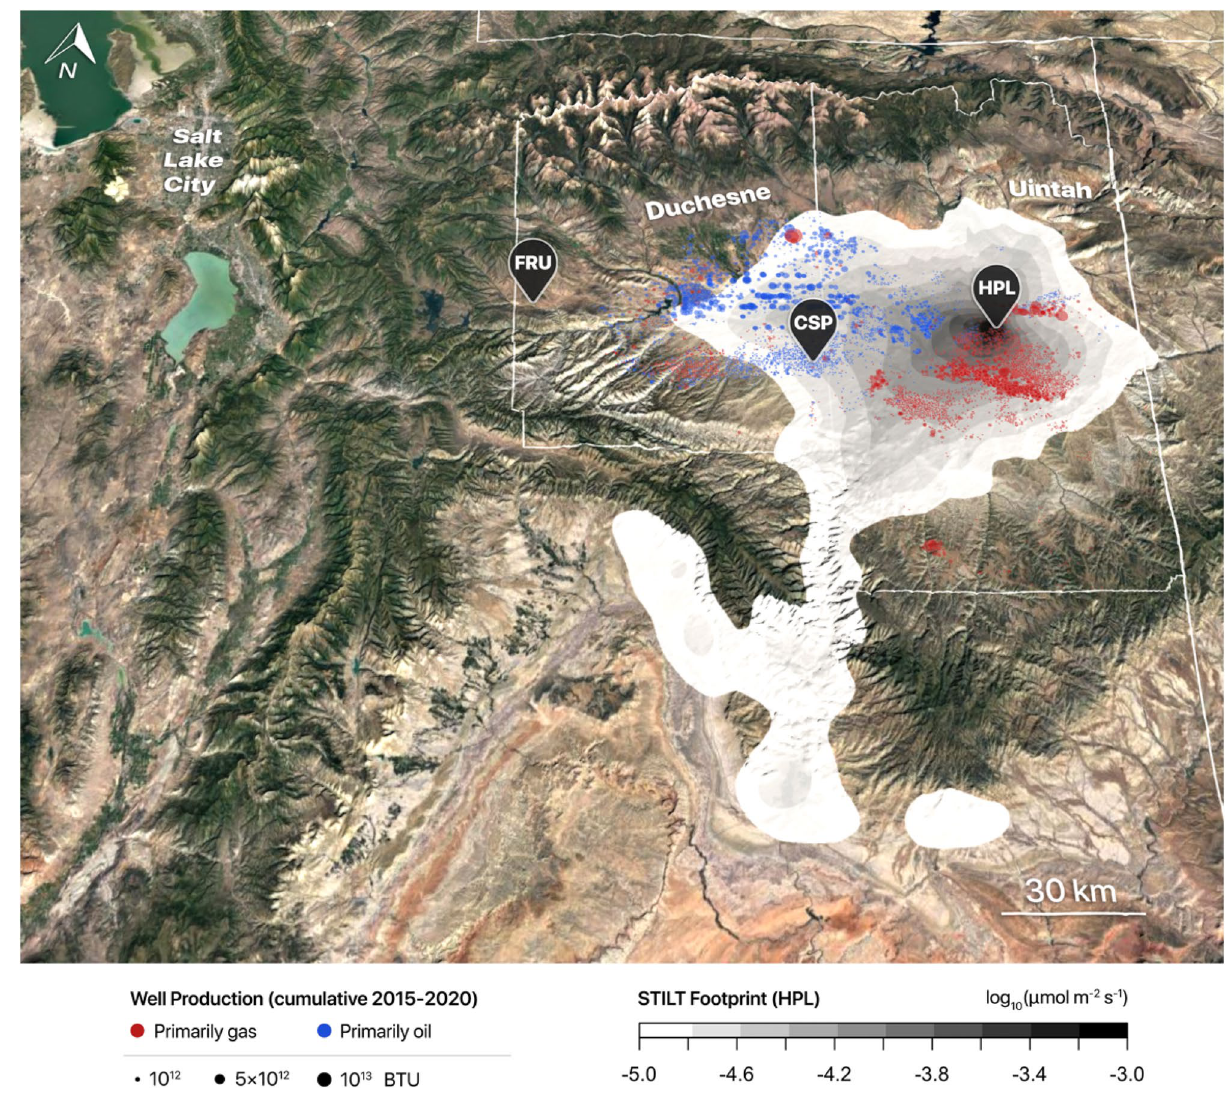
Figure 1. Map of the Uinta Basin in eastern Utah, CH 4 observational sites, and oil/gas wells. Observational sites indicated by the black pins are: Horsepool (HPL), Castlepeak (CSP), and Fruitland (FRU). Locations of wells are indicated by circles, respectively. The well sizes reflect the cumulative production of energy (in [Btu]) from the sum of both natural gas and oil, using conversion factors described in the “Methods” section. If more energy is produced from natural gas, the well is colored in red, while wells producing more energy from oil is colored in blue. The east–west partitioning of gas versus oil wells also correspond geographically to the Uintah and Duchesne counties, which are separately dominated by gas and oil wells, respectively. The grayscale is the atmospheric footprint of the HPL site [ppm/(μmole m −2 s −1 )] as simulated by HRRR-STILT, averaged over the subset of months (Apr to Sep) and afternoon hours (13:00 to 16:00 MST) from 2015 to 2020 used to calculate CH 4 emissions. The underlying satellite image was generated from Google Earth, with data from: Landsat/ Copernicus, TerraMetrics,